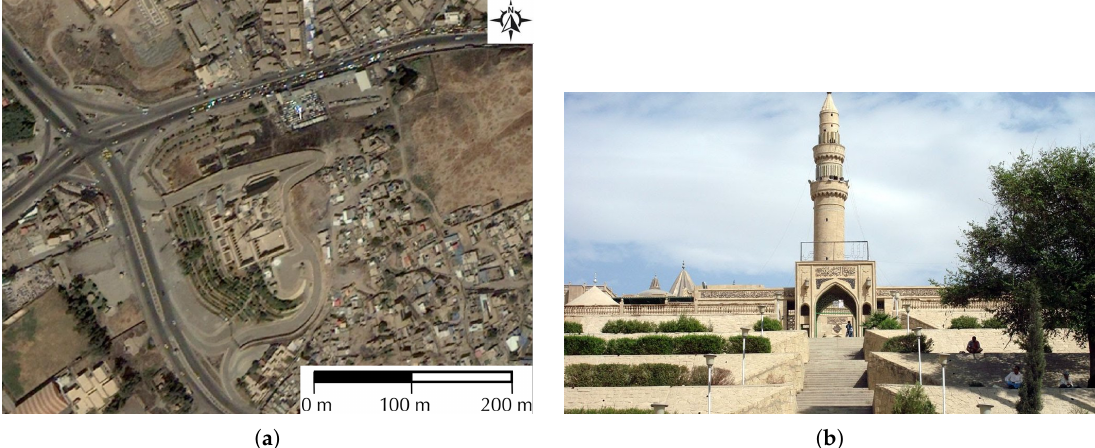
Figure 15. Overview of the Nebi Yunus Mosque before the destruction: ( a ) QuickBird, 19 July 2014 c (cid:13) DigitalGlobe; and ( b ) ground picture in 2013 [74].